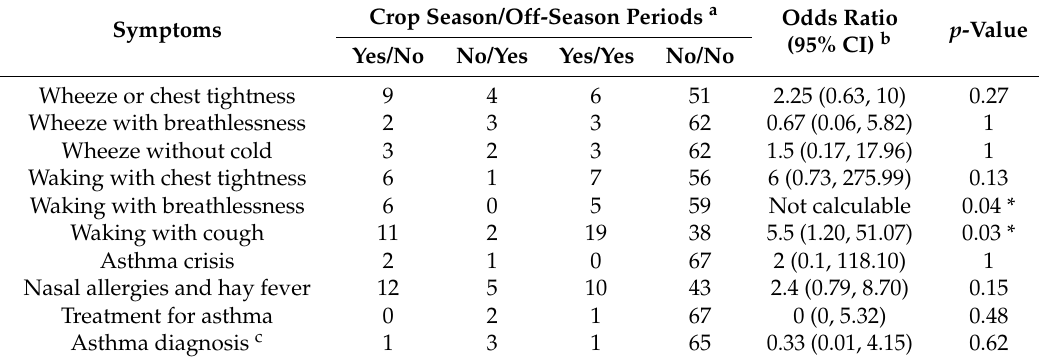
Table 2. Comparison of respiratory symptoms prevalence between crop season (2014) and off-season (2015), using the ECRHS questionnaire in SJU. Crop Season/Off-Season Periods a Odds Ratio Symptoms